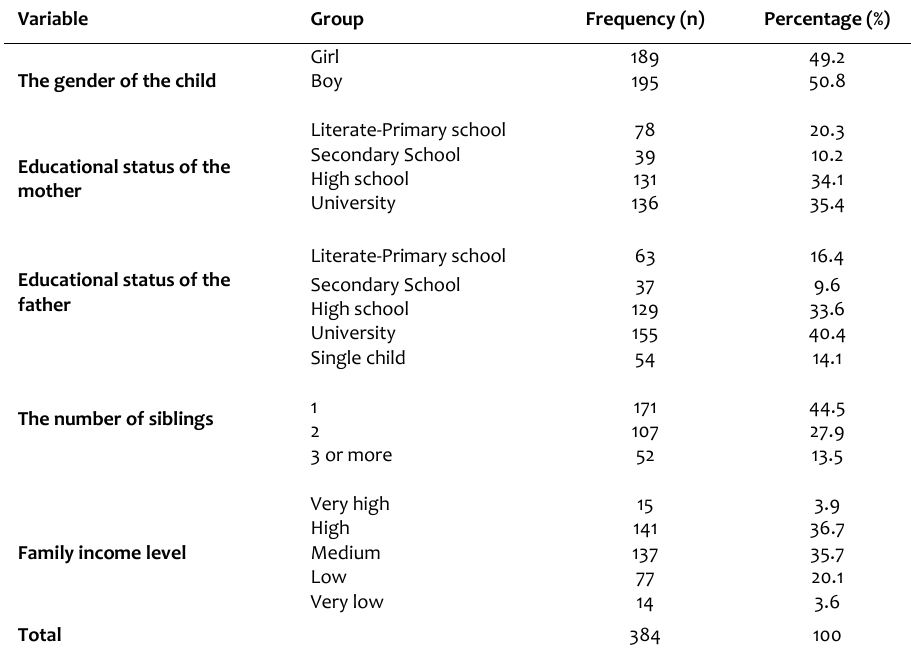
Table 2. Distribution of Demographic Information of the Children